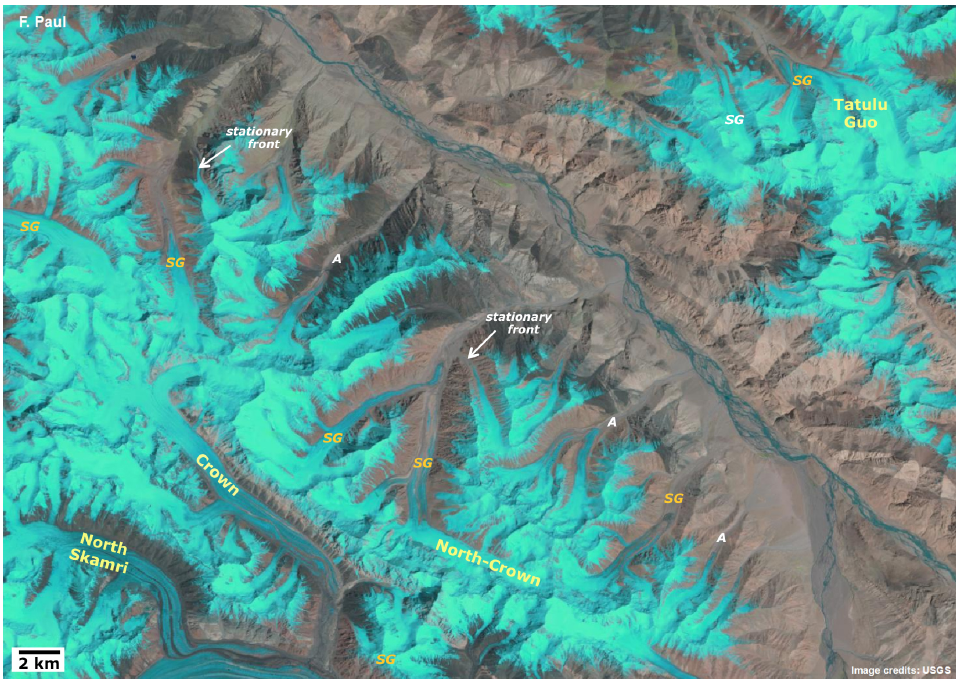
Figure 5. Subregion (4) (Shaksgam) shows the region to the north of Skamri Glacier to both sides of the Shaksgam Valley; annotations and Landsat scene as in Fig.